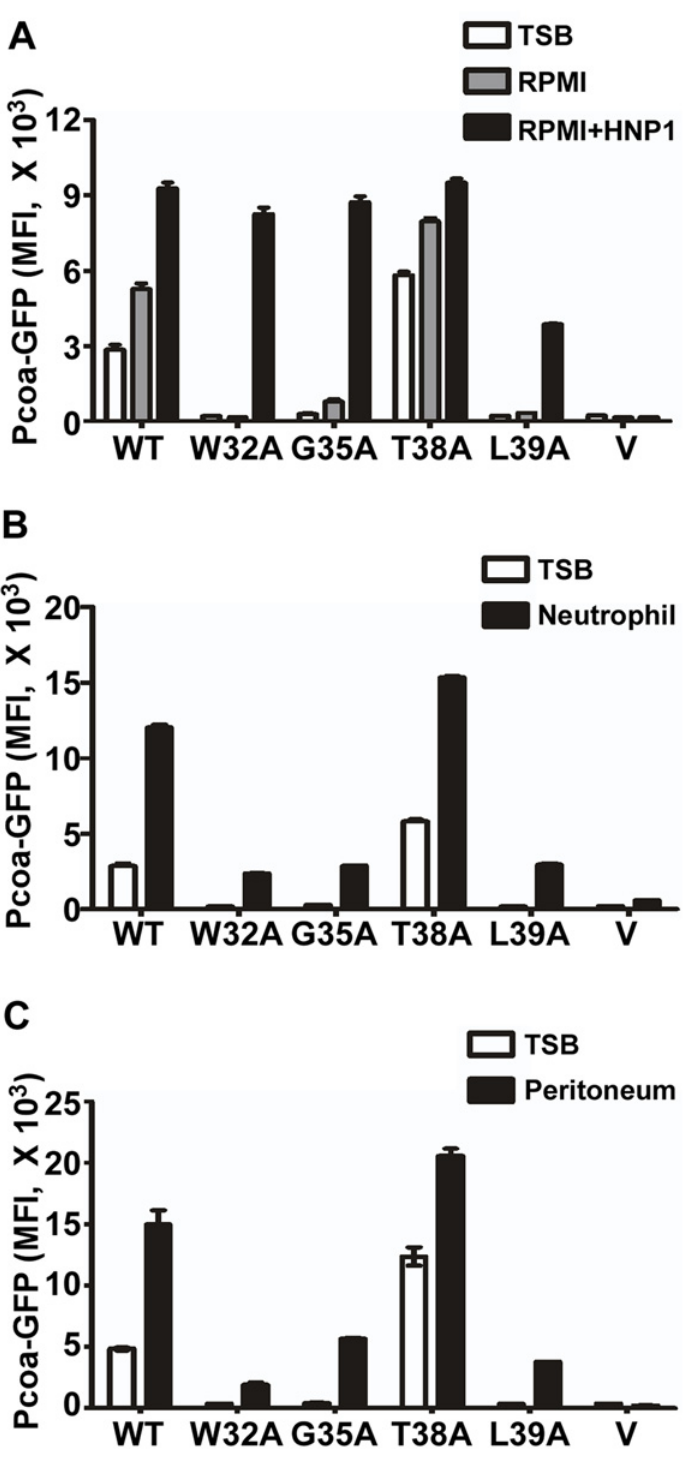
Fig 8. The wild type SaeS shows the most robust switch function in clinically relevant environments. (A) The effect of the growth medium RPMI on the switch function of wild type and select linker peptide mutants of SaeS. Cells were grown in RPMI until exponential growth phase. For induction of the SaeRS TCS, HNP1 (5 μ g/ml) was added, and the culture was further incubated for 2 h. Expression of GFP was measured by flow cytometry. The GFP expression in TSB is also shown for comparison. Error bars represent